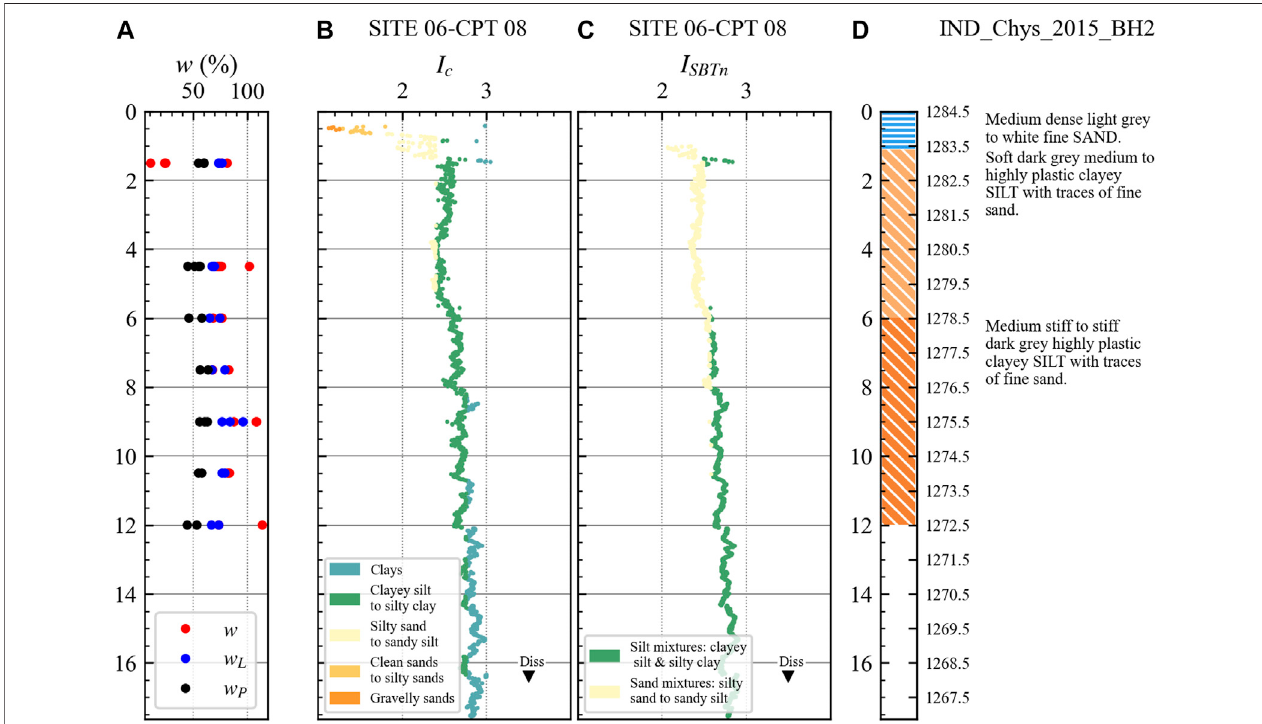
FIGURE 8 | (A) Water content and plastic limits from borehole site Chys_2015 from database (SAFER/GEO-591; Gilder et al., 2019a; Gilder et al., 2020) (B) soil behavior type designation I c (Been and Jefferies, 1993) from the CPTu pro fi le site 06 CPT08 (C) soil behavior type designation I SBTn (Robertson and Wride, 1998), updated in Robertson (2009) site 06 CPT08 (D) Chys_2015 borehole